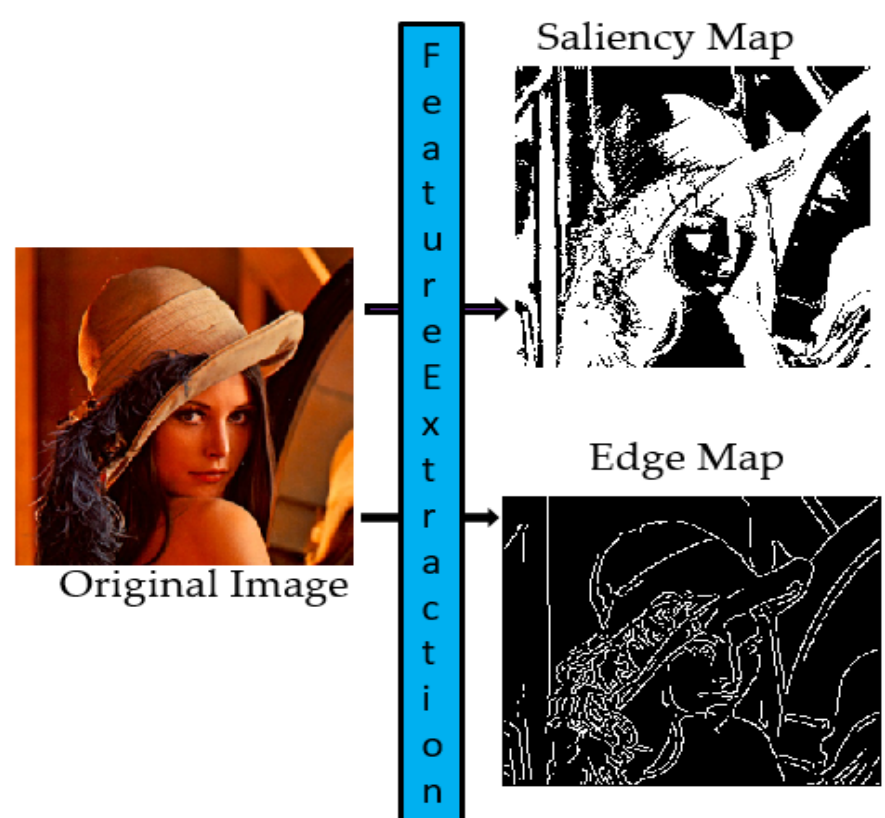
Figure 2. Saliency and Edge Map Representation.